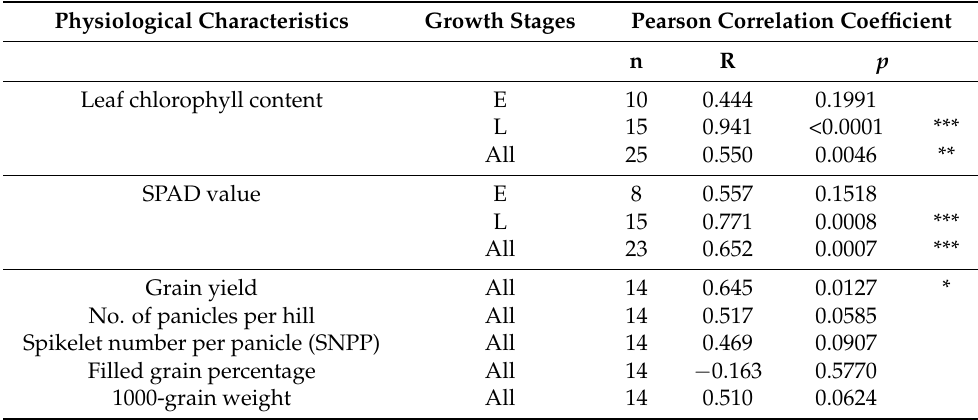
Table 4. Correlation between the NDVI and physiological characteristics. The E growth stage refers to the earlier growth stages, ET and LT stages. The L growth stage refers to the later growth stages; SE, B, and F stages. n, R, and p refer to the number of plots, the Pearson correlation coefficient, and the p -value, respectively (* p < 0.05; ** p < 0.01; *** p <